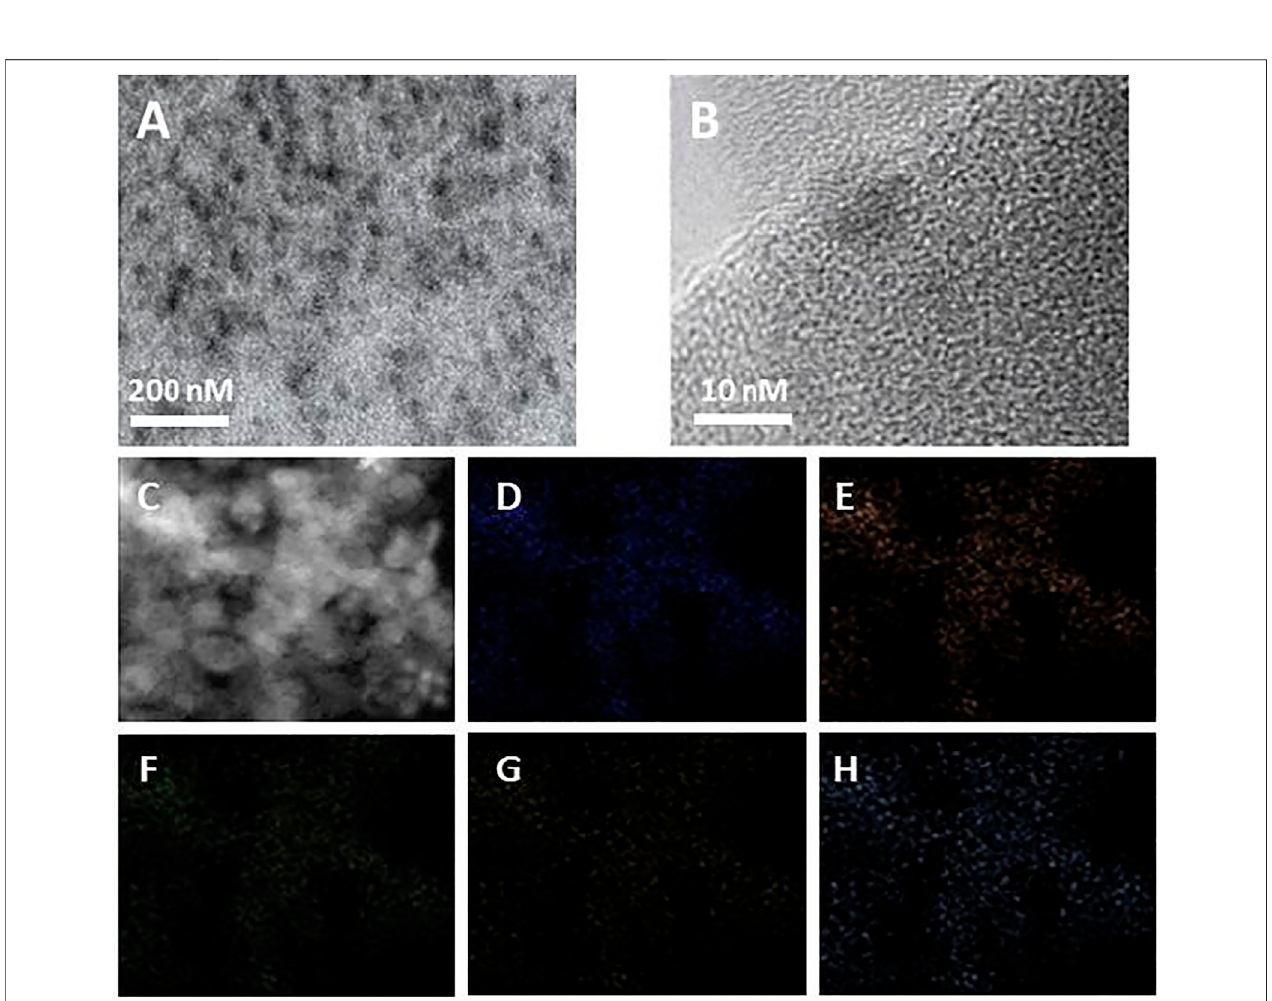
Frontiers in Chemistry |